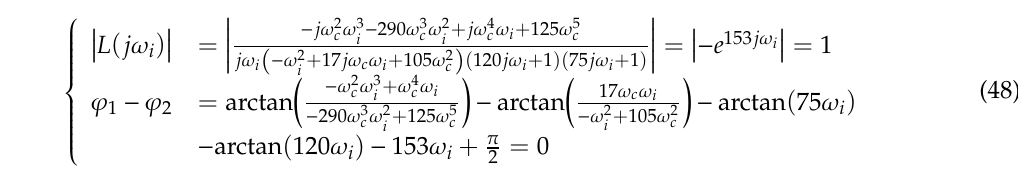
Figure 8. Processes 2020 , 8 , x FOR PEER REVIEW